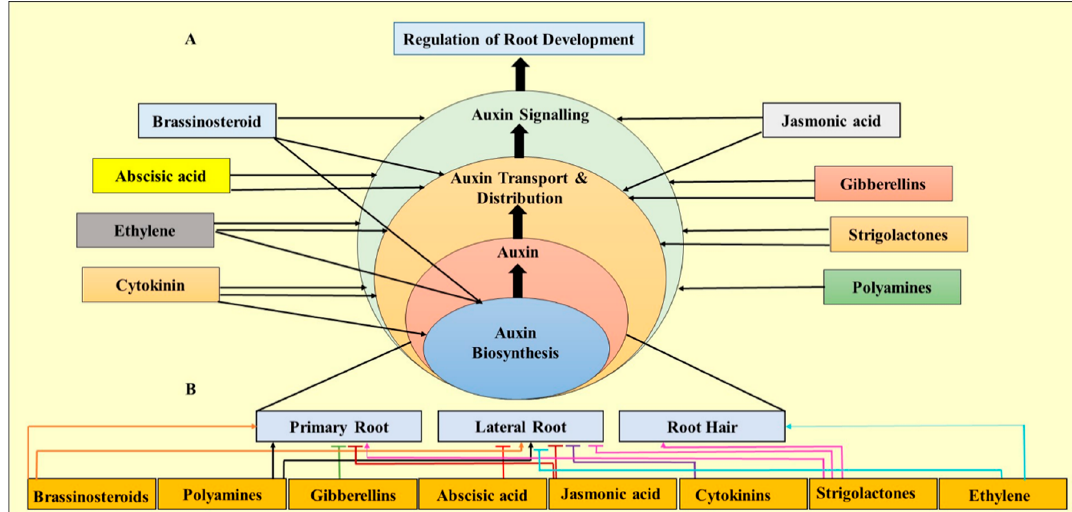
Figure 3. The schematic graph of phytohormone signalling in root development. For root growth and development, auxin is moved from cell to cell by appropriate auxin influx and efflux transporters, such as p-glycoproteins (PGPs), pin formed (PIN), and like-aux1 (LAX) proteins. ( A ) antagonistic or synergistic activities of auxins with other plant growth regulators, and ( B ) controlling root morphogenesis and elongation by integrating the hormonal signals in transport and distribution of auxin biosynthesis.